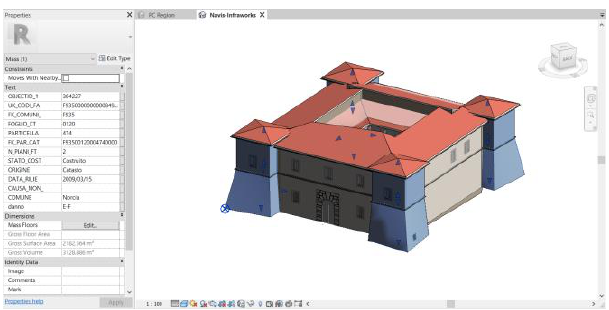
Figure 11. The results of the Dynamo assignment on the Castellina model.